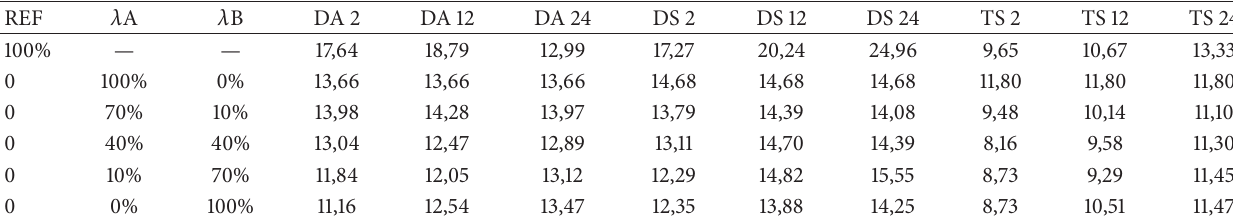
Table 1: Quality of forecast results using nRMSE evaluation